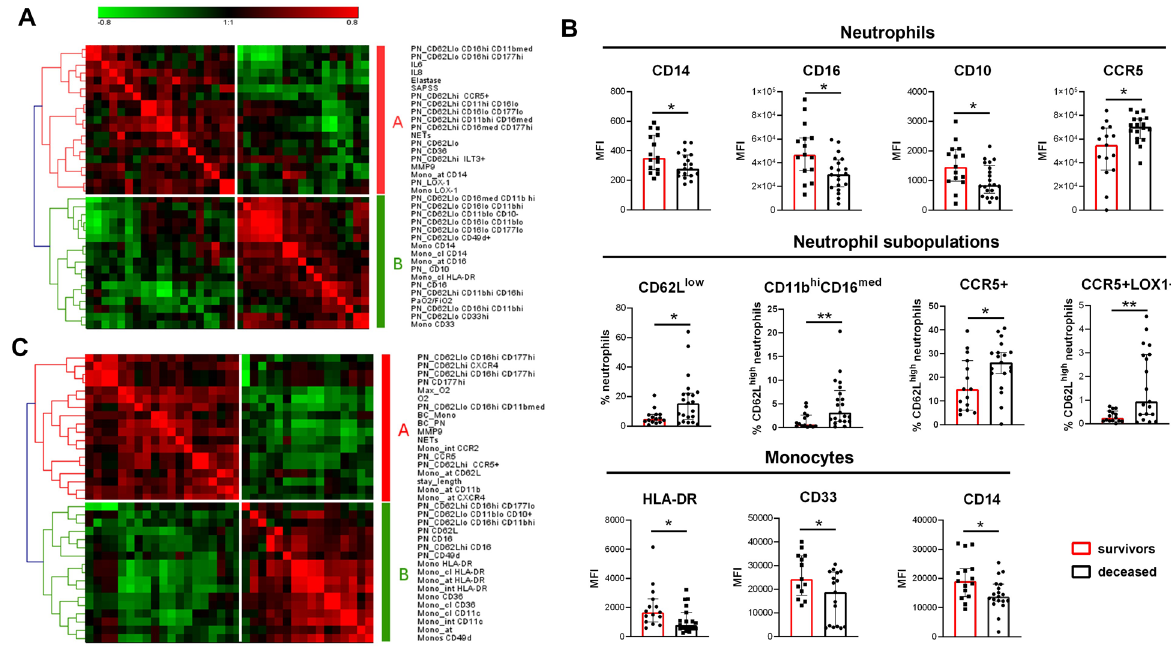
Figure 3. Association of innate immunity-related markers with severity. ( A ) Hierarchical clustering of the correlation matrix from phenotypic and soluble markers significantly correlated with SAPS II score or the PaO 2 / FiO 2 ratio in ICU patients. Red is for positive correlation and green for negative correlation. Intensity of color is proportional to Spearman correlation coefficient. Cluster A groups markers with a correlation profile similar to SAPS II score. Cluster B groups markers with correlation profiles similar with PaO 2 /FiO 2 ratio. ( B ) Markers significantly different between patient who survived (red) or died (black) during their ICU stay. The histograms represent the median and the error bars the interquartile range. Intergroup comparison by Mann–Whitney U test between survivors and deceased patients, **P < 0.01, *P < 0.05. ( C ) Hierarchical clustering of the correlation matrix from phenotypic and soluble markers significantly correlated with external oxygen requirement on the day of sampling (O 2 ), maximal external oxygen requirement (Max_O2) or length of hospitalization in non-ICU patients (stay_lengh). Red is for positive correlation and green for negative correlation. Intensity of color is proportional to Spearman correlation coefficient. Cluster A groups markers with a correlation profile similar to O2, Max_O2 and stay_length. Cluster B groups markers negatively correlated to cluster A. BC_PN: neutrophil absolute count; BC_Mono: monocyte absolute count. Hierarchical clustering was made with Genesis 1.8.1 (Gratz University of Technology, https:// genome. tugraz. at/ genes iscli ent/ genes iscli ent_ descr iption.